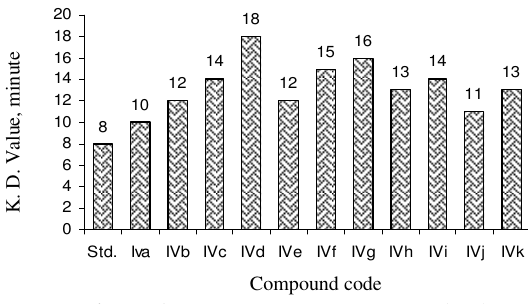
Figure 2. Insecticidal activity of